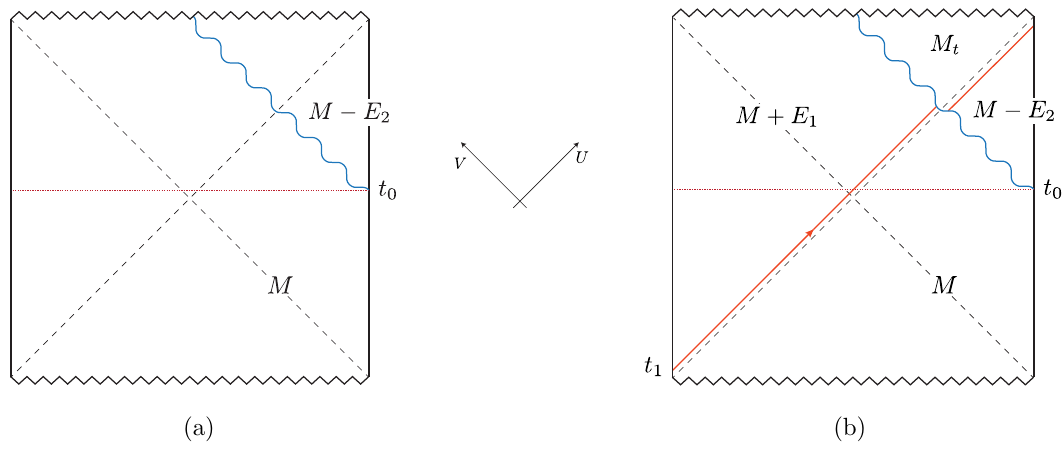
Figure 6. Penrose diagrams of the di(cid:11)erent shockwave geometries. In (a), we only consider the e(cid:11)ect of a negative energy shock of energy (cid:0) E 2 (blue curvy line) sent at t 0 . In (b), we add the e(cid:11)ect of a second shock with positive energy E 1 sent at t 1 from the left boundary (solid red